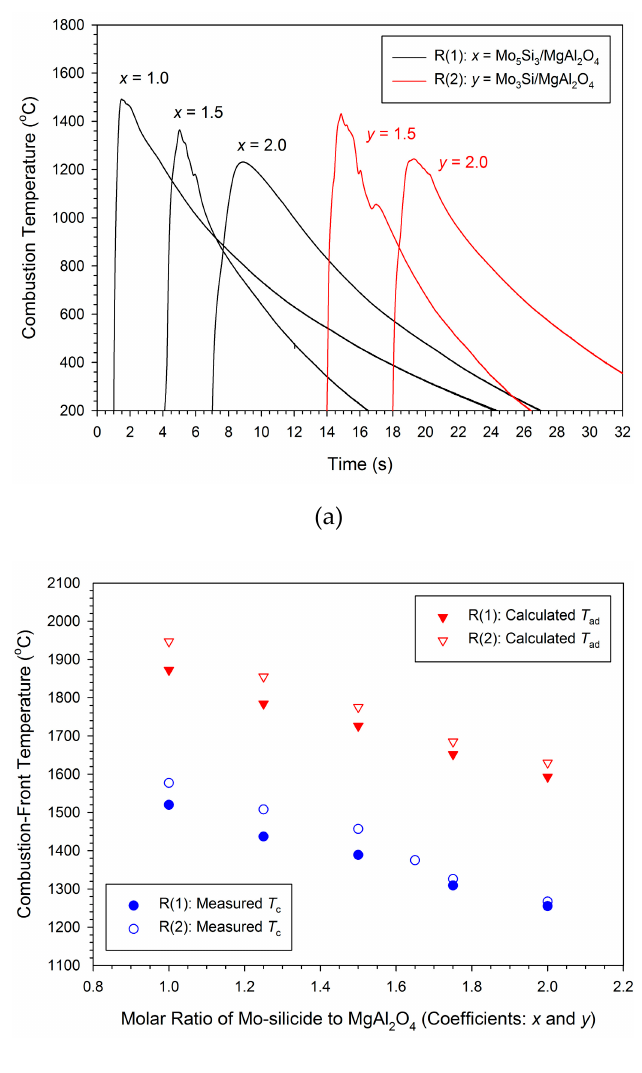
Figure 3. Effect of molar ratio of Mo-silicide to MgAl 2 O 4 on combustion temperatures of Reactions (1) and (2): ( a ) Typical temperature profiles and ( b ) combustion front temperatures.